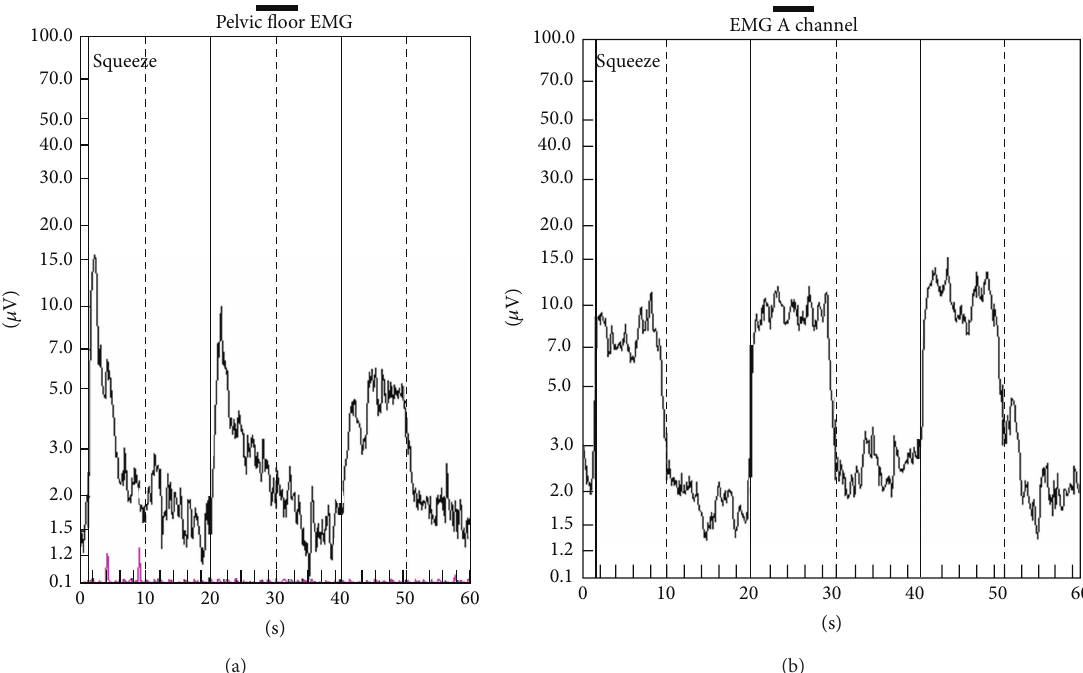
Figure 4: Endurance training. (a) Electromyographic tracings of a patient with fecal incontinence (black tracing) showing inability to maintain sustained contractions (poor endurance) and characteristic sawtooth pattern indicating fatigue. (b) Electromyographic tracings of the same patient following pelvic muscle rehabilitation sessions revealing sustained contractions during each interval